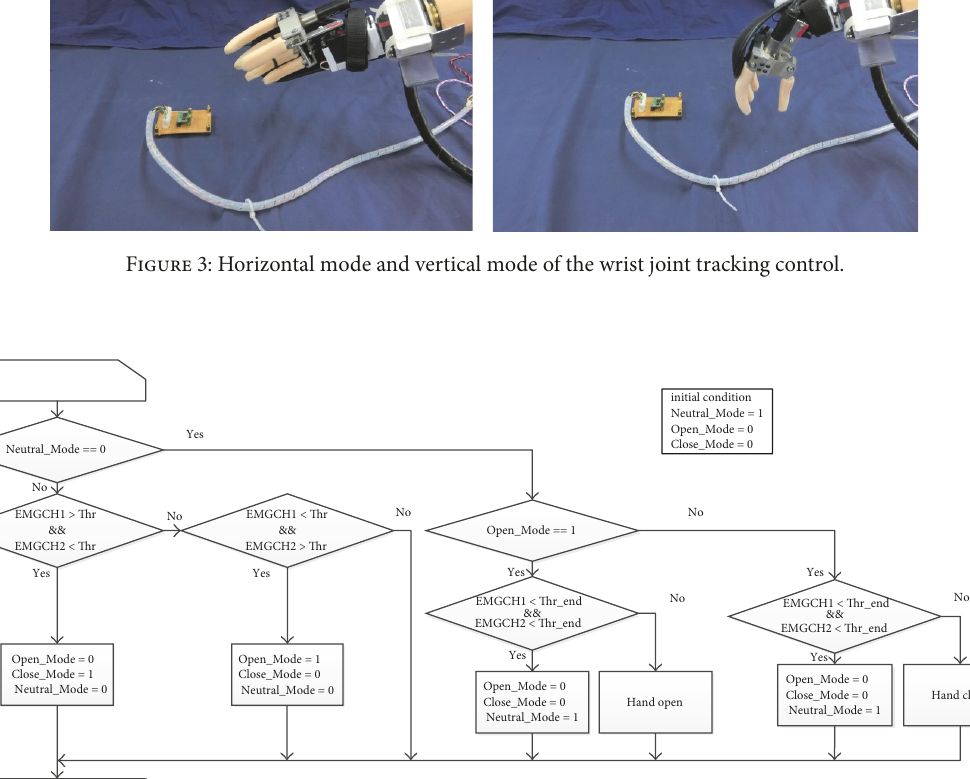
Flexion/extension angle = − ( − 90 + work plane pitch angle − forearm pitch angle)